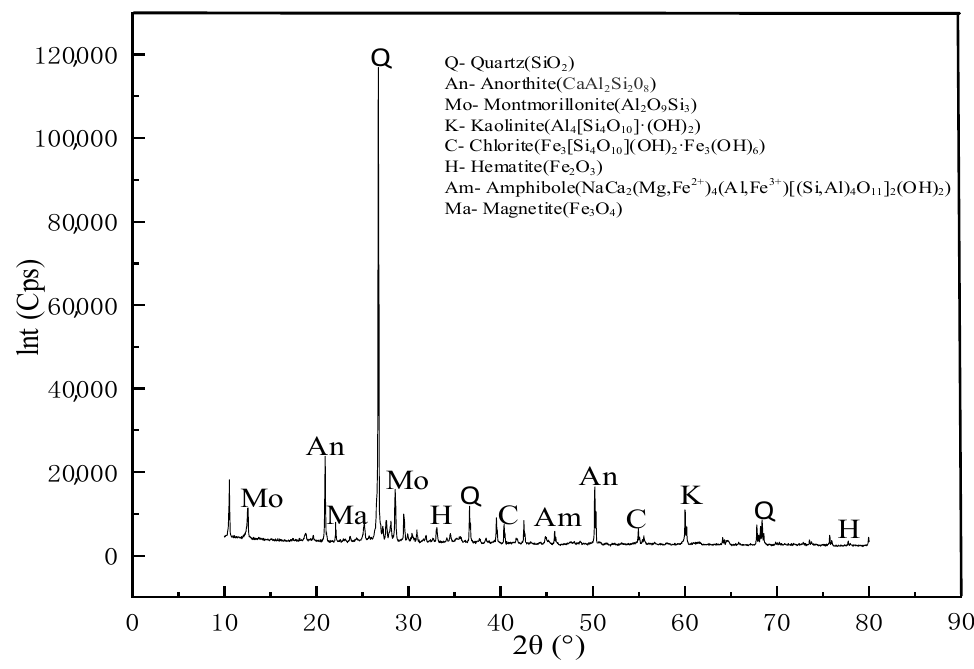
Figure 2. XRD analysis of overflow ultra-fine iron tailings.